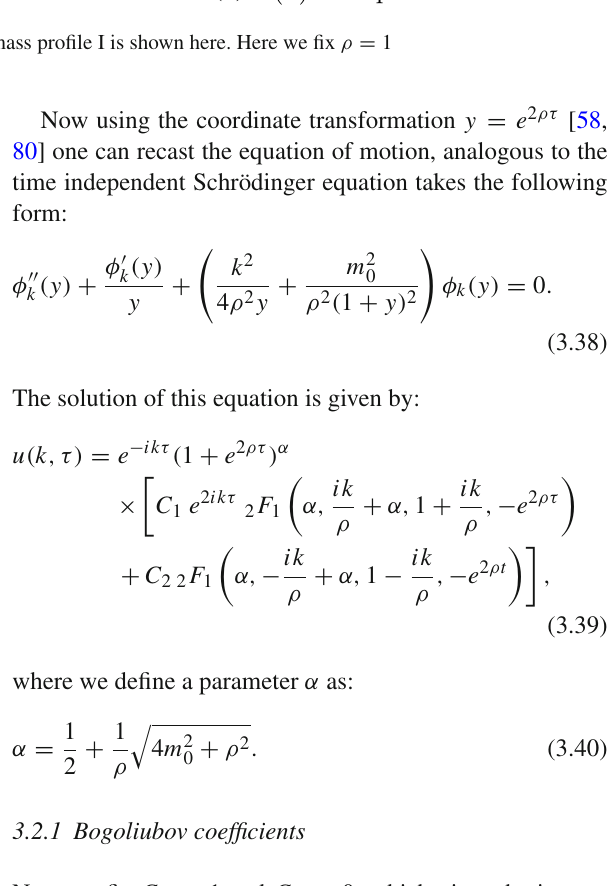
(b) r ( k ) vs k plot.